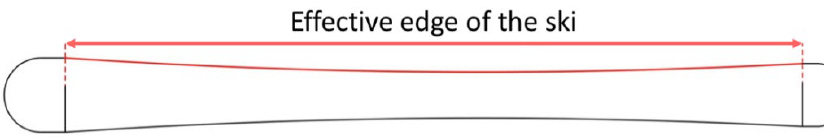
Figure 5. Effective edge of the ski.